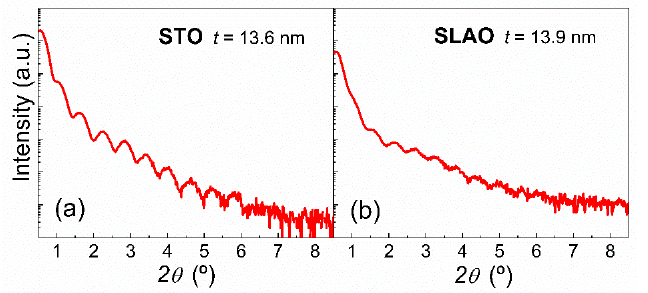
Figure 1. X-ray reflectivity measurements of La 1 − x Sr x CoO 3 (LSCO) films grown on SrTiO 3 (STO) ( a ) and Sr 0.3 La 0.7 AlO 4 (SLAO) ( b ) substrates for one representative thickness (about 14 nm).